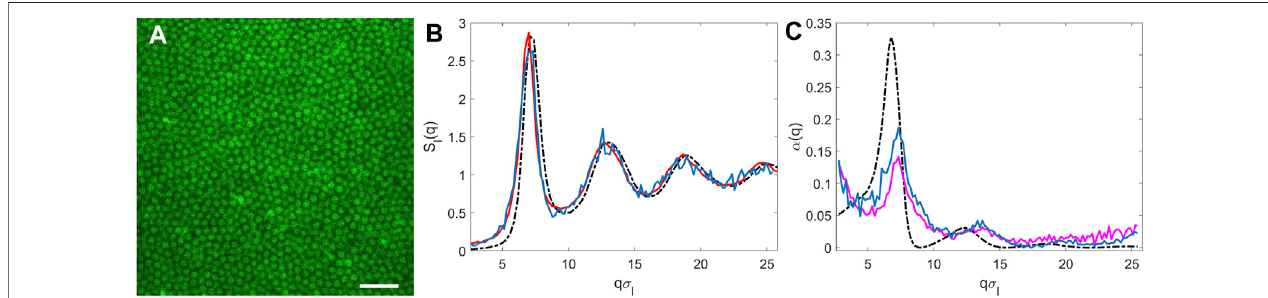
FIGURE6| Structurefactor ofthelargeparticlesandestimationofthenon-ergodicityfactorfor ϕ =0.60. (A) Minimumprojectionoftheimagesequence.Thescale bar corresponds to 15 μ m. (B) Experimental 2D structure factor (blue), simulated 2D structure factor (red), and simulated 3D structure factor (dash-dotted black) of the largespheres. (C) non-ergodicity factor, asobtainedbythe fi tofthecollectiveISFusing Eq.6 for f self ( q , Δ t ) (blue), byevaluatingtheISFat a fi xedtime delay Δ t =10 4 sas reported in [39] (magenta) and from simulated data using Eq. 21 (dashed-dotted